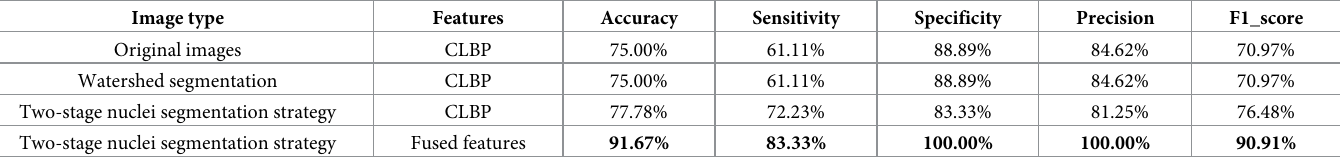
Table 6. Comparison of image segmentation results under different conditions at